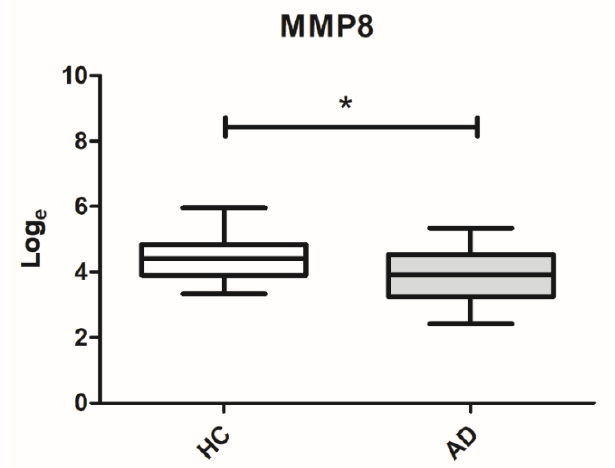
Figure 3. Box plot for MMP8 levels (log scale) in the GCF of individuals with atopic dermatitis and healthy controls. HC: Healthy control; AD: Atopic dermatitis; * p < 0.05.